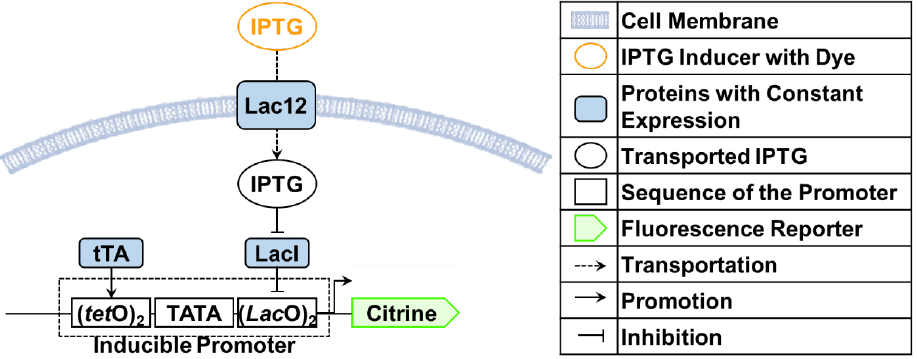
Figure 1. The inducible promoter designed by Gnügge et al. [37]. (Figure is modified from a related work from Bandiera et al.